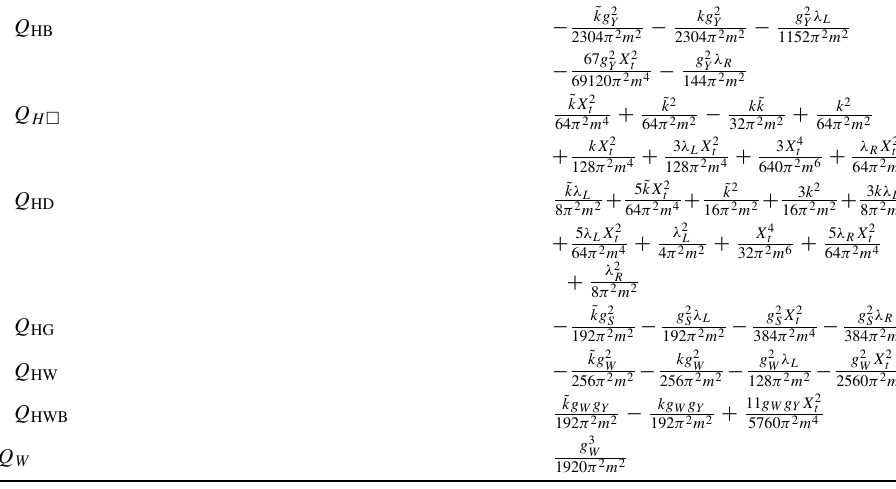
(cid:5) ¯ l γ μ q ) Scalar–Fermion μ l )( ¯ q γ